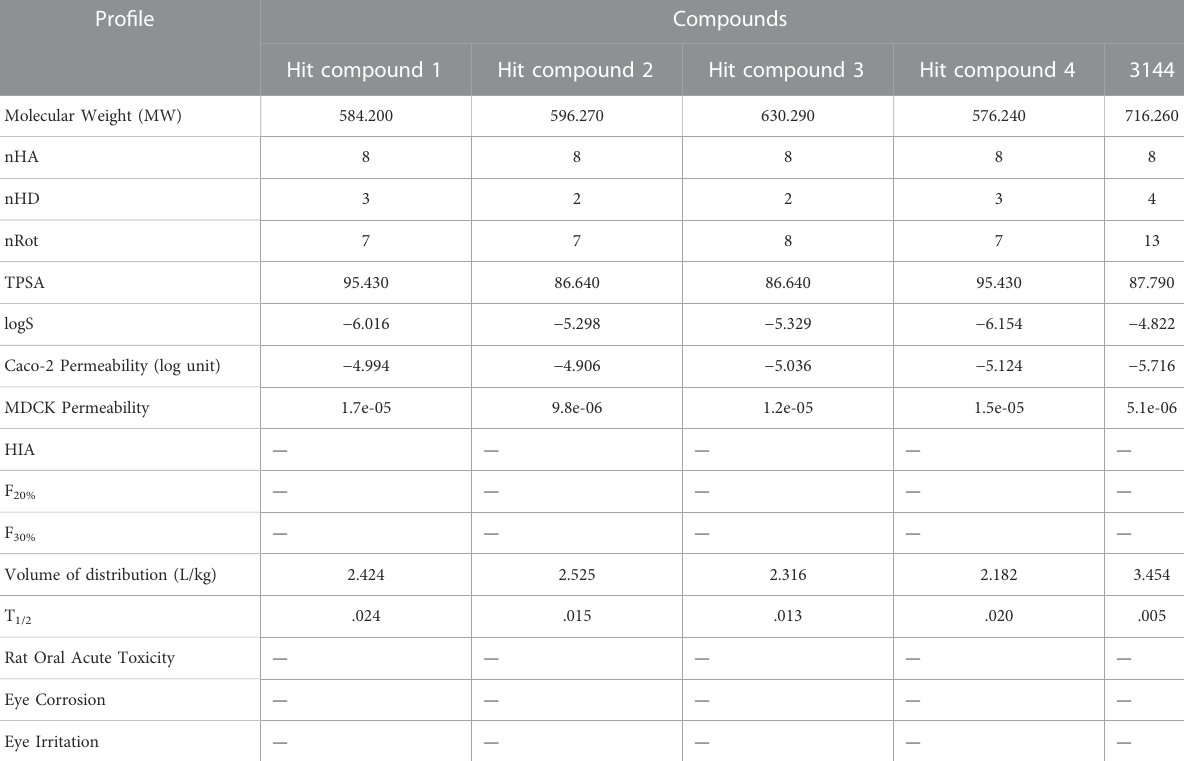
TABLE 1 Pharmacokinetic pro fi le of the four hit compounds and reference 3144. Pro fi